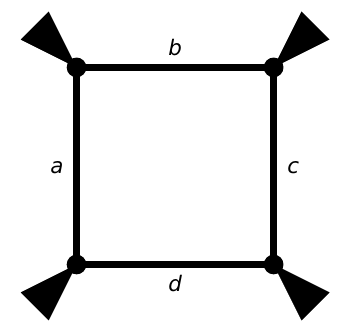
Figure 1 . The four-mass box